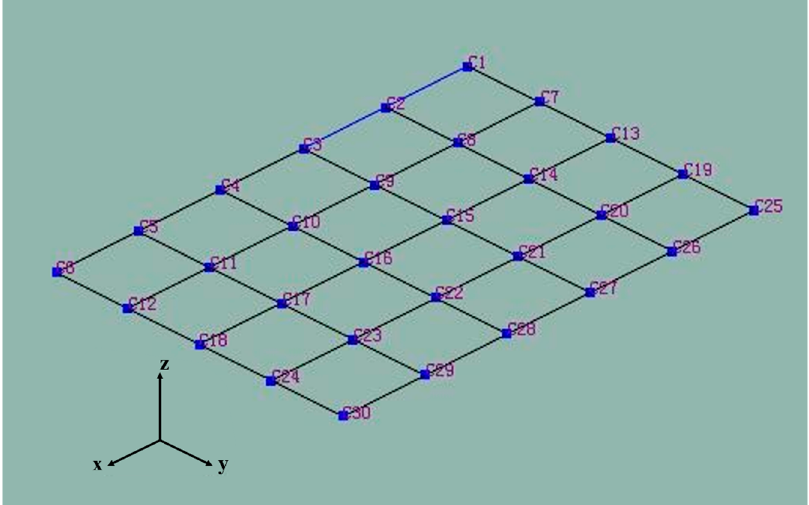
Figure 4. Meshing during the mode experiment.